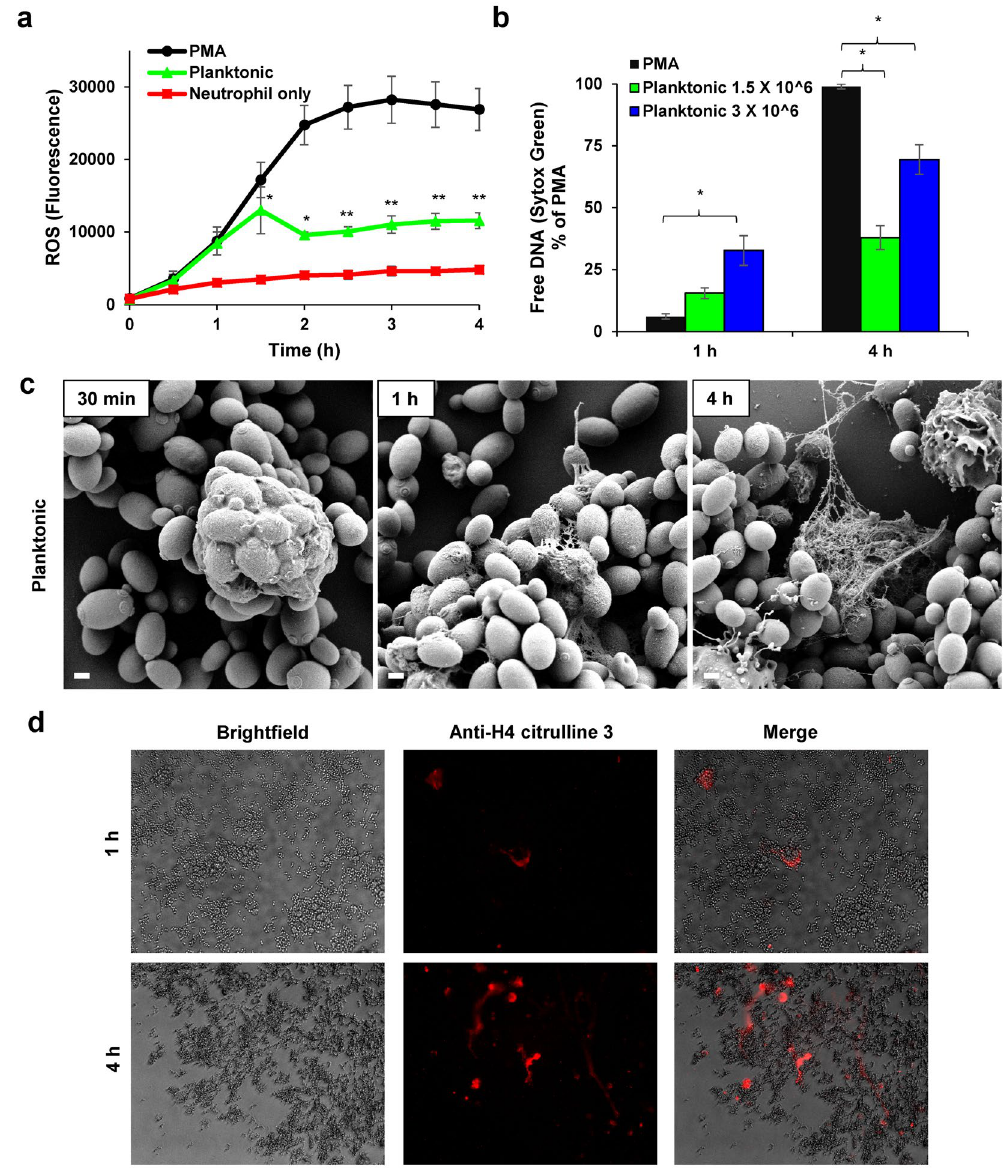
Figure 2. Mechanism of NET release to planktonic C . glabrata . ( a ) Production of ROS in response to C . glabrata (CG 006 at 3 × 10 6 cells/well) was measured by fluorescence after neutrophils were pre-stained with oxidative stress indicator CM-DCF and co-cultured with C . glabrata over 4 h. The mean and SEM of 4 experiments performed in triplicate on 4 occasions are shown. Data for each time point were analyzed by ANOVA ( * P < 0 . 05 ), with pairwise comparisons using the Holm-Sidak method ( ** P < 0 . 05 for C . glabrata v. PMA). ( b ) Neutrophils were co-cultured with planktonic C . glabrata for various time points and NET production was estimated by Sytox Green. Results were normalized to the positive control, PMA, and data